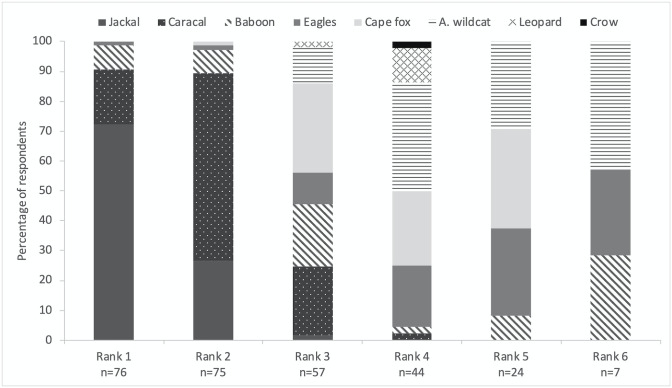
Ranking of predators.Histogram showing the percentage of farmers who ranked eight species and categories of predators from the first (Rank 1) to the last (Rank 6) cause of livestock losses on their small-livestock farms in the Central Karoo District, South Africa. The number of farmers identifying a predator species for each rank (n) is given under the rank number. “A. wildcat” represents “African wildcat”.